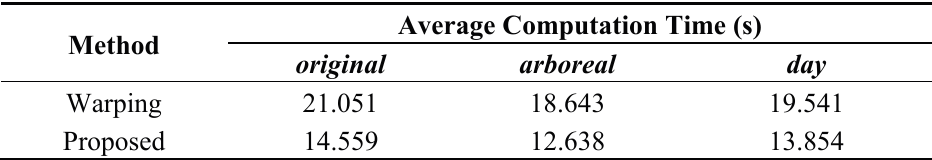
Table 2. Average computation time for the two